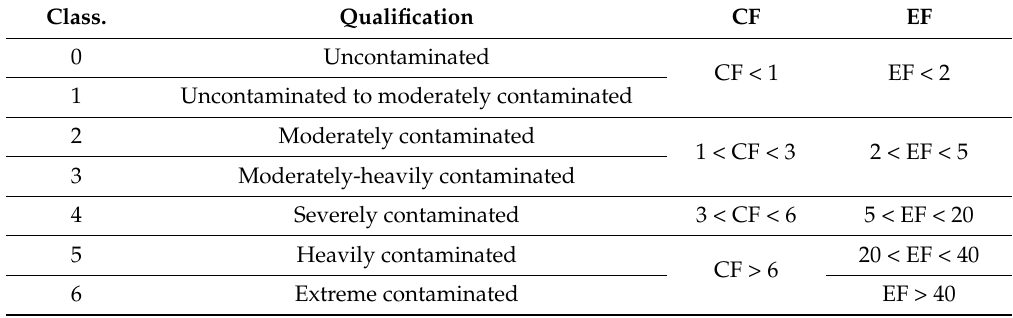
Table 3. Soil quality classification for CF (contamination factor) and EF (enrichment factor). Class. Qualification CF EF 0 Uncontaminated CF < 1 EF < 2 1 Uncontaminated to moderately contaminated 2 Moderately contaminated 1 < CF < 3 2 < EF < 5 3 Moderately-heavily contaminated Severely contaminated 3 < CF <